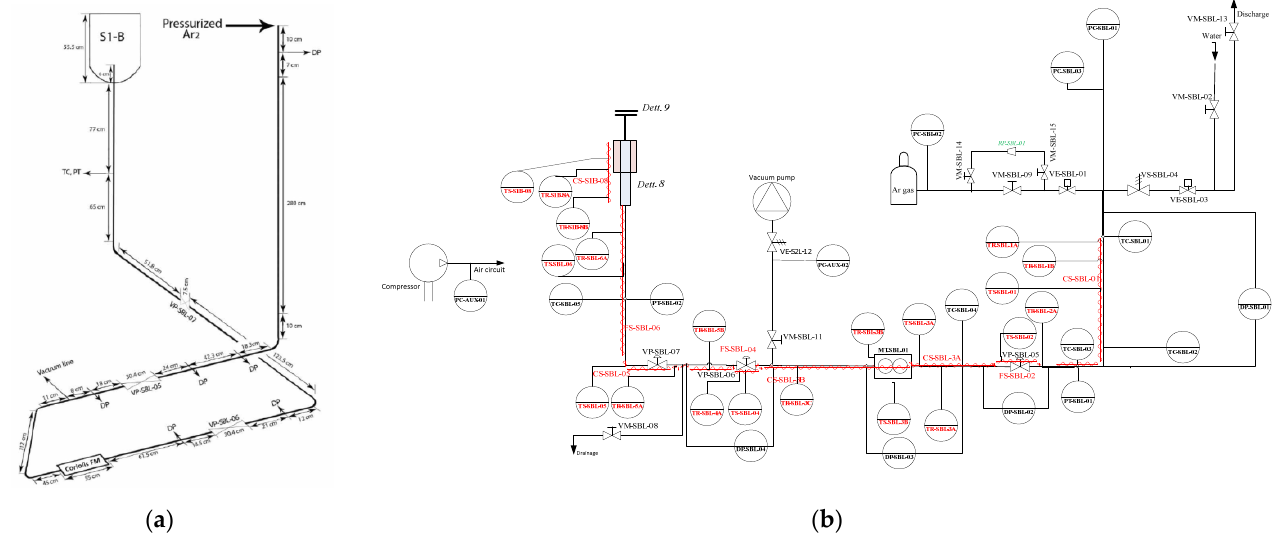
Figure 4. Schematic drawings of the injection line. ( a ) Injection line layout and components positioning; ( b ) injection line P&ID.